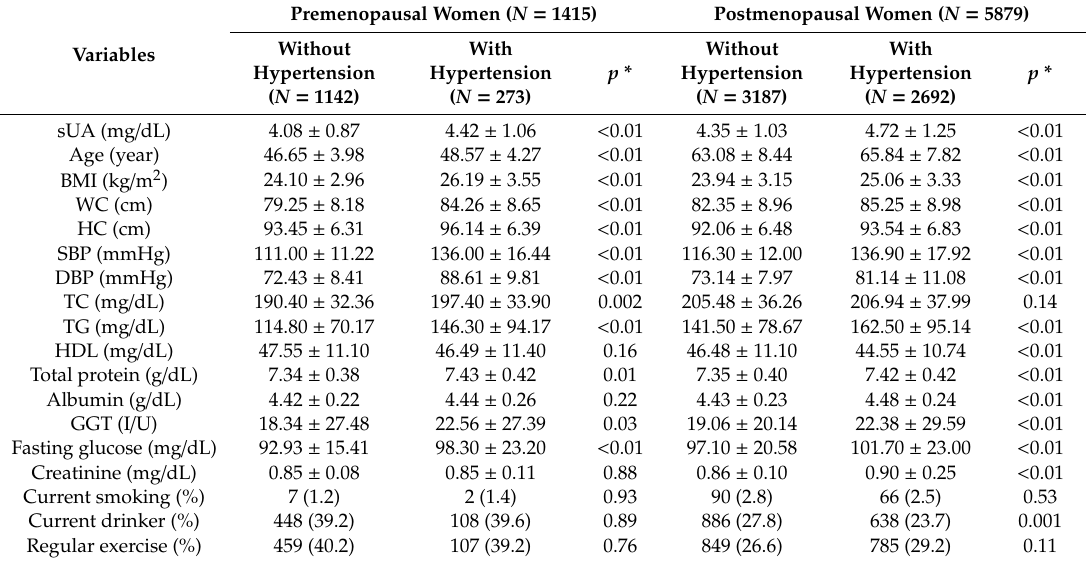
Table 2. Anthropometric characteristics of premenopausal and postmenopausal women with